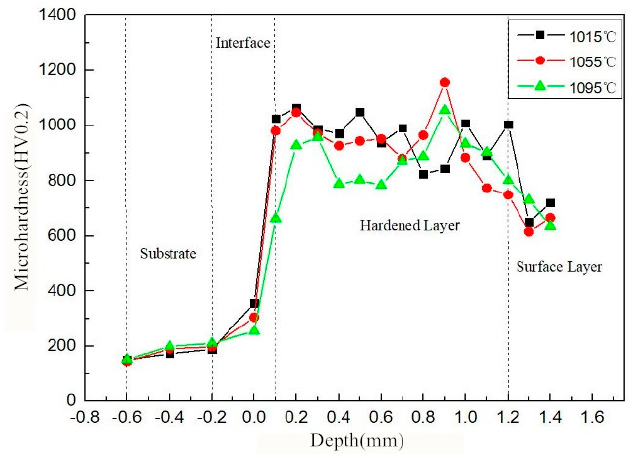
Figure 10. Microhardness of the composite coatings section.